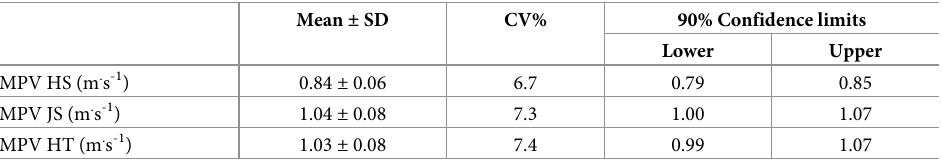
Table 4. Mean ± standard deviation (SD), between subject coefficient of variation (CV), and 90% confidence lim- its of the mean propulsive velocities (MPV) associated with the maximum mean propulsive power values in the half-squat (HS), jump squat (JS), and hip-thrust (HT) exercises in top-level sprinters and